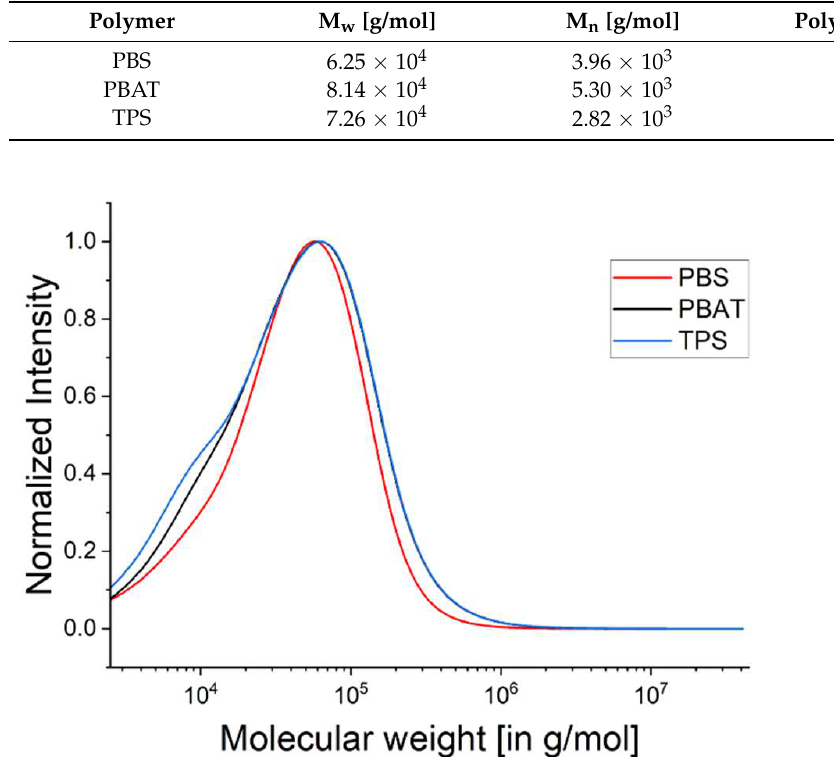
Figure 3. GPC elugrams before rheological measurement representing the biopolymers PBS, PBAT and TPS.